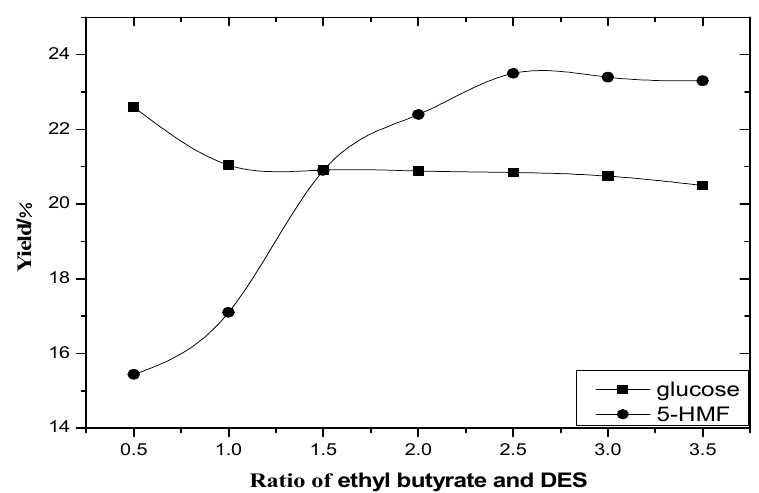
Figure 1. E ff ect of the ratio of ethyl butyrate and DES on products Figure 1. Effect of the ratio of ethyl butyrate and DES on products yields.